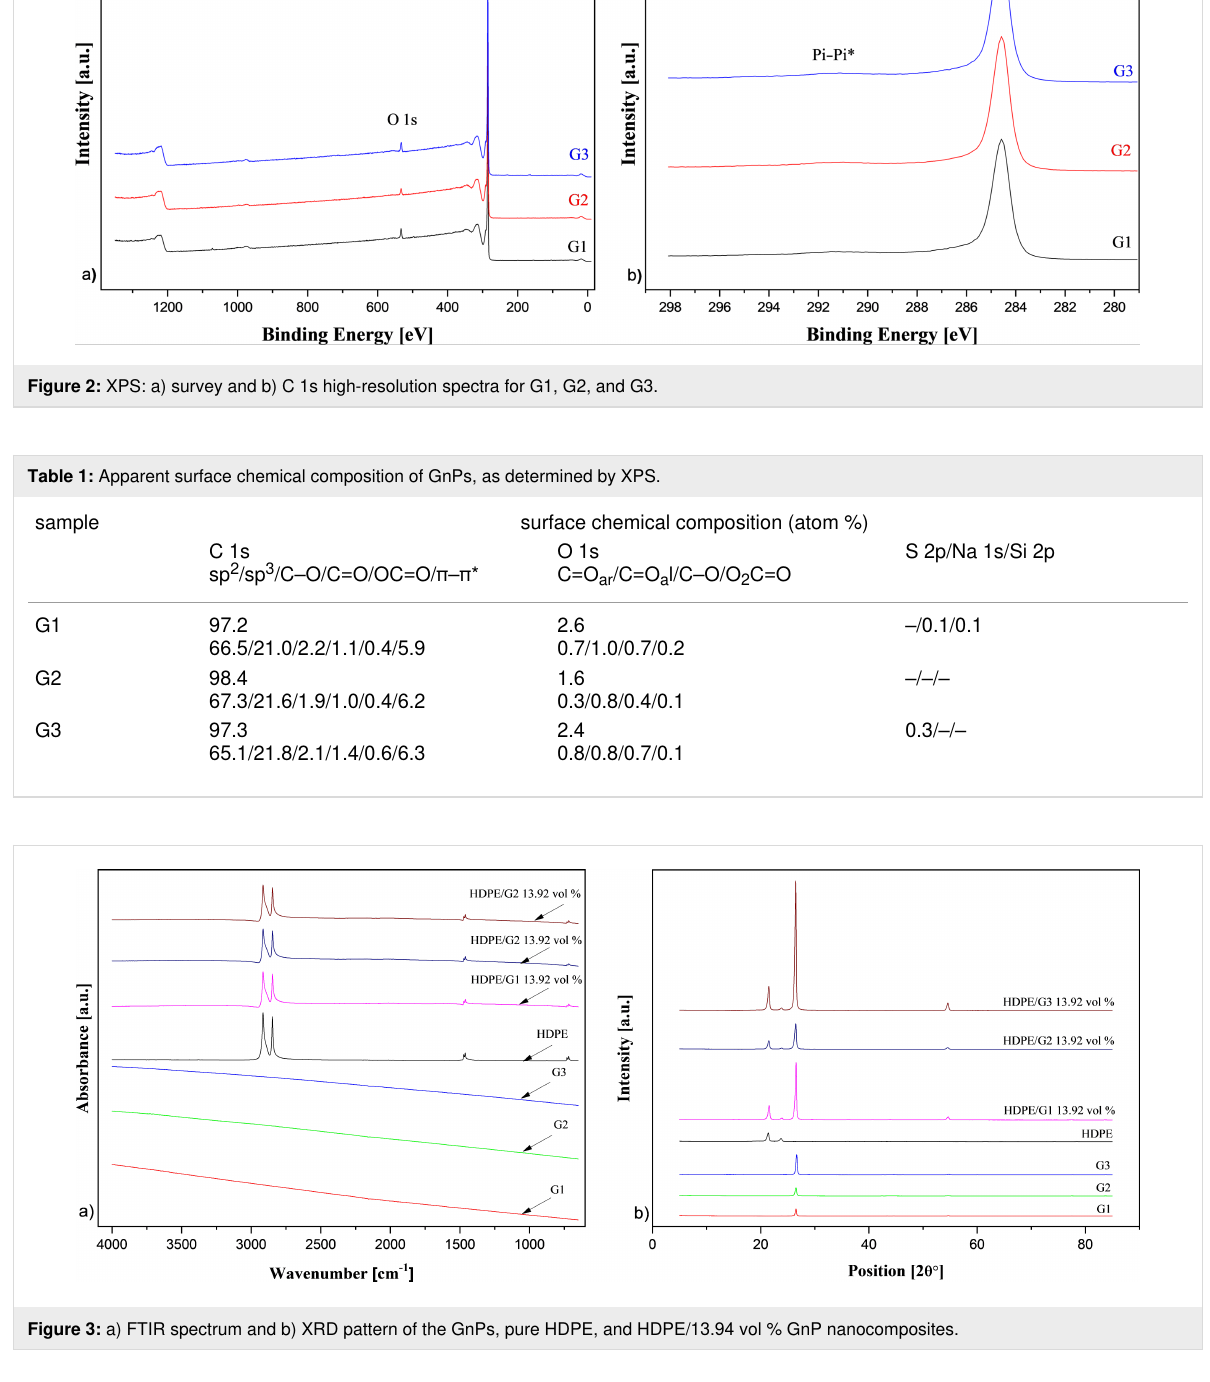
File 1). The spectrum of HDPE showed two strong peaks at 2914.86 cm − 1 and 2847.37 cm − 1 , respectively, and four weak peaks at 1472.59 cm − 1 , 1462.11 cm − 1 , 730.28 cm − 1 , and 718.84 cm − 1 . The peaks at ≈ 2914 cm − 1 and ≈ 2847 cm − 1 were assigned to alkyl (C–H) stretch vibrations. The peaks at the